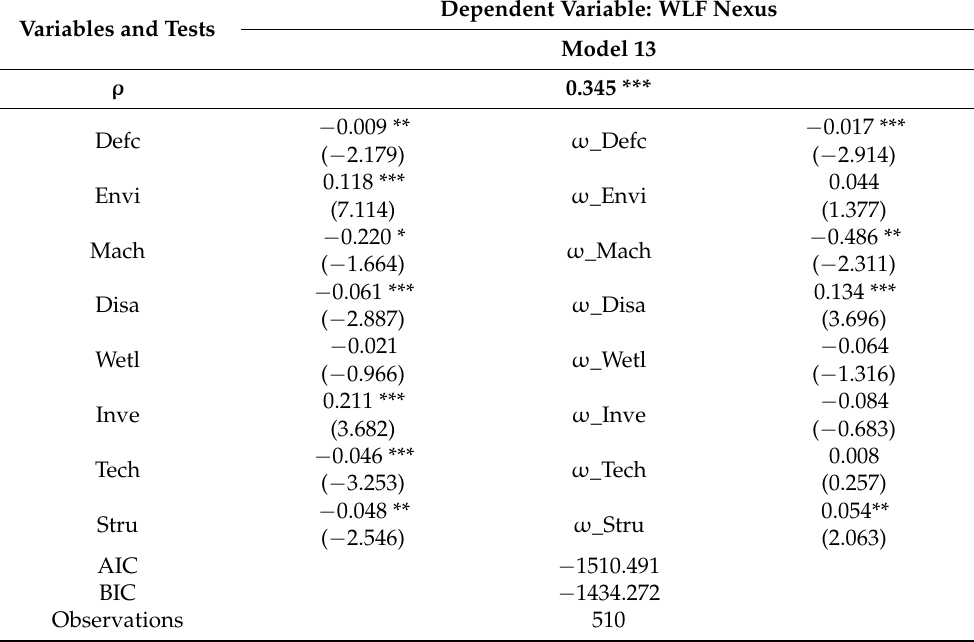
Table 7. Regression results of Spatial Panel Dubin